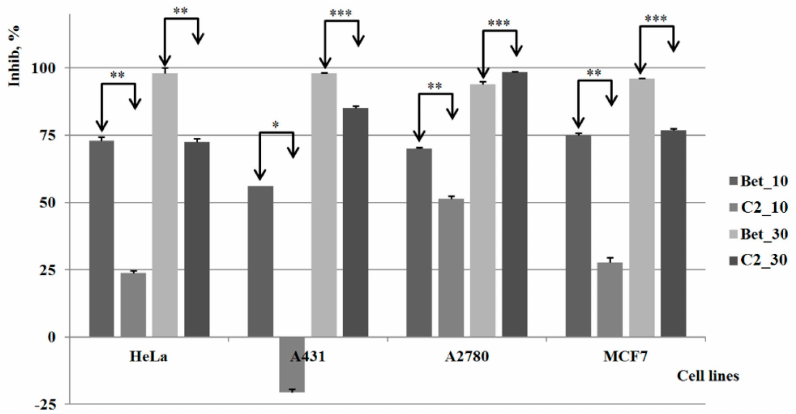
Figure 5. The results of the in vitro tests for C2 vs. control group (Bet) *, **, *** indicate p < 0.05, p < 0.01, and p <